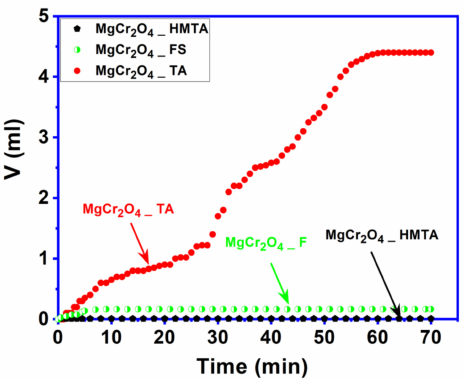
Figure 6. Catalytic activity of MgCr 2 O 4 nanoparticles on the reaction of hydrogen peroxide